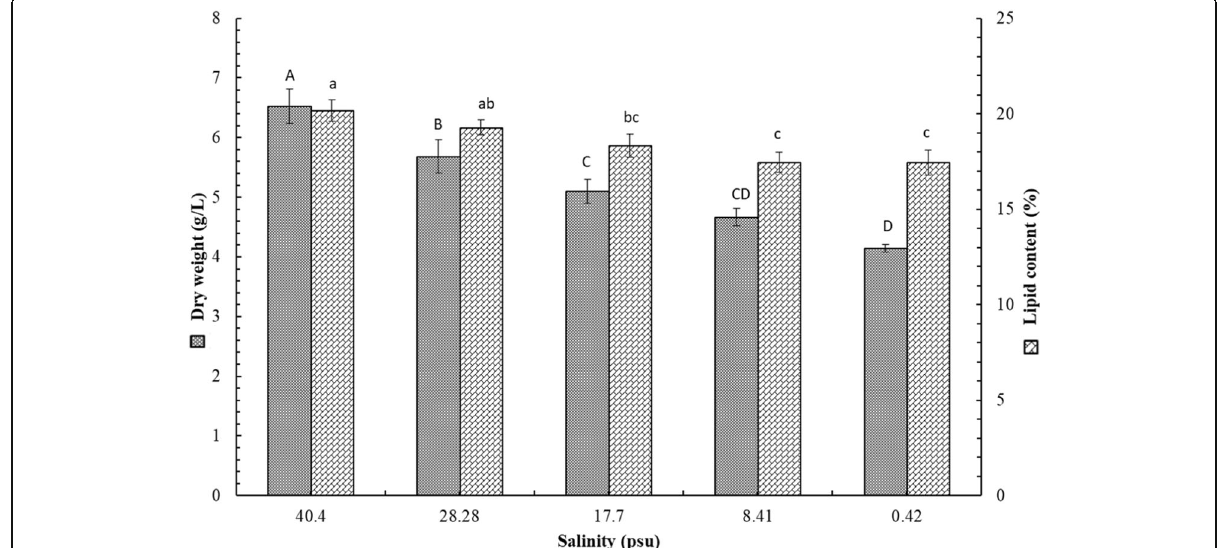
Fig. 6 Biomass productivity (g l − 1 ) and oil content (% oil/g of dry algal biomass) of Chlorella sp. MF1 under different salinity treatments. Different letters indicate statistically significant differences between the treatments using Tukey ’ s